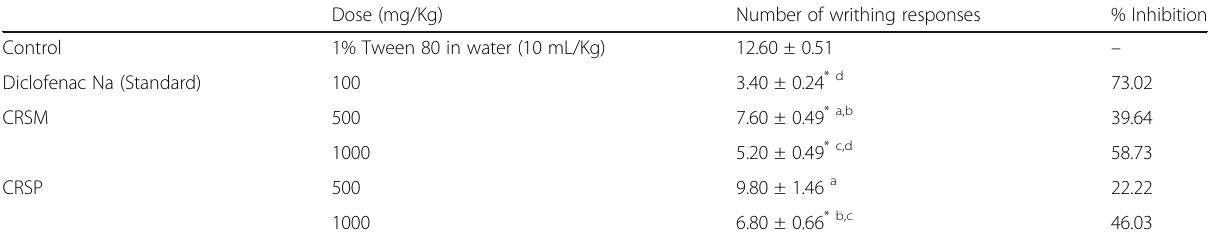
Table 7 Effects of C. renigera seed methanol and petroleum ether extracts in acetic acid induced writhing